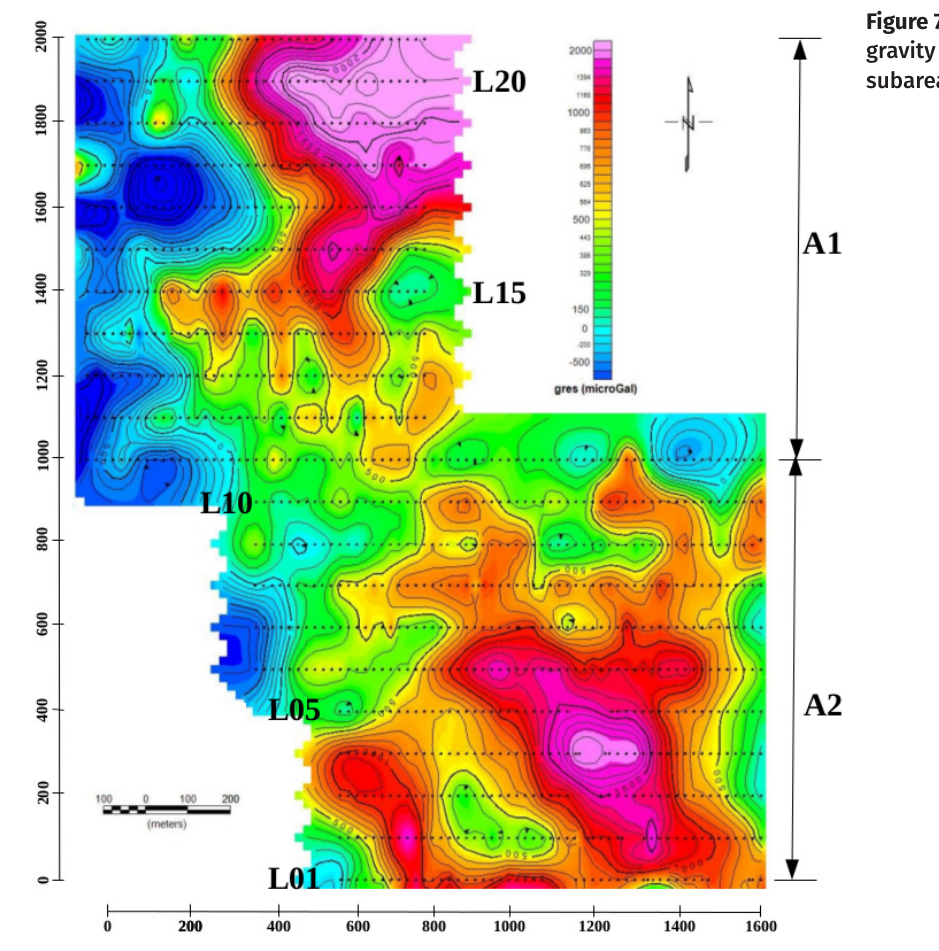
Figure 7. Residual gravity map of subareas A1 and